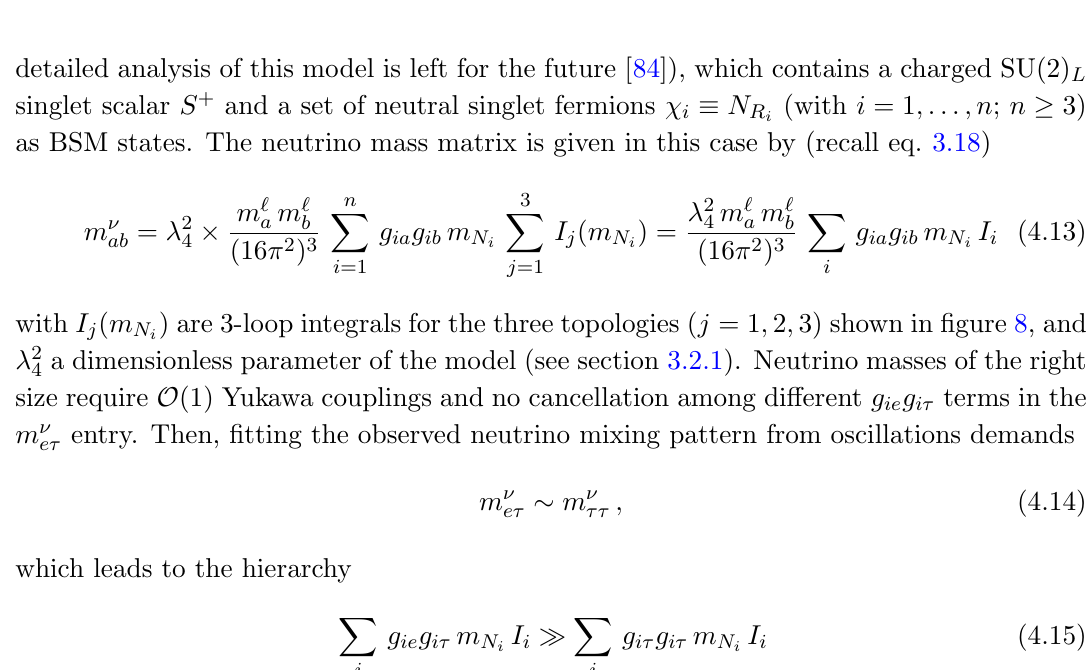
Figure 11 . Neutrinoless double (cid:12) -decay 1-loop contributions to section 3.2.1. BSM propagators are depicted in